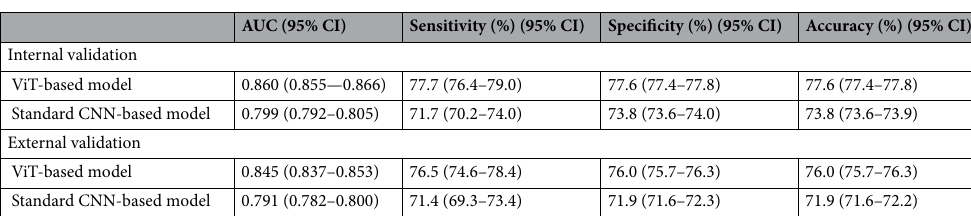
Table 2. Performance of the deep learning models for frame-level diagnosis in the internal and external validation. AUC area under the curve, CI confidence interval, PPV positive predictive value, NPV